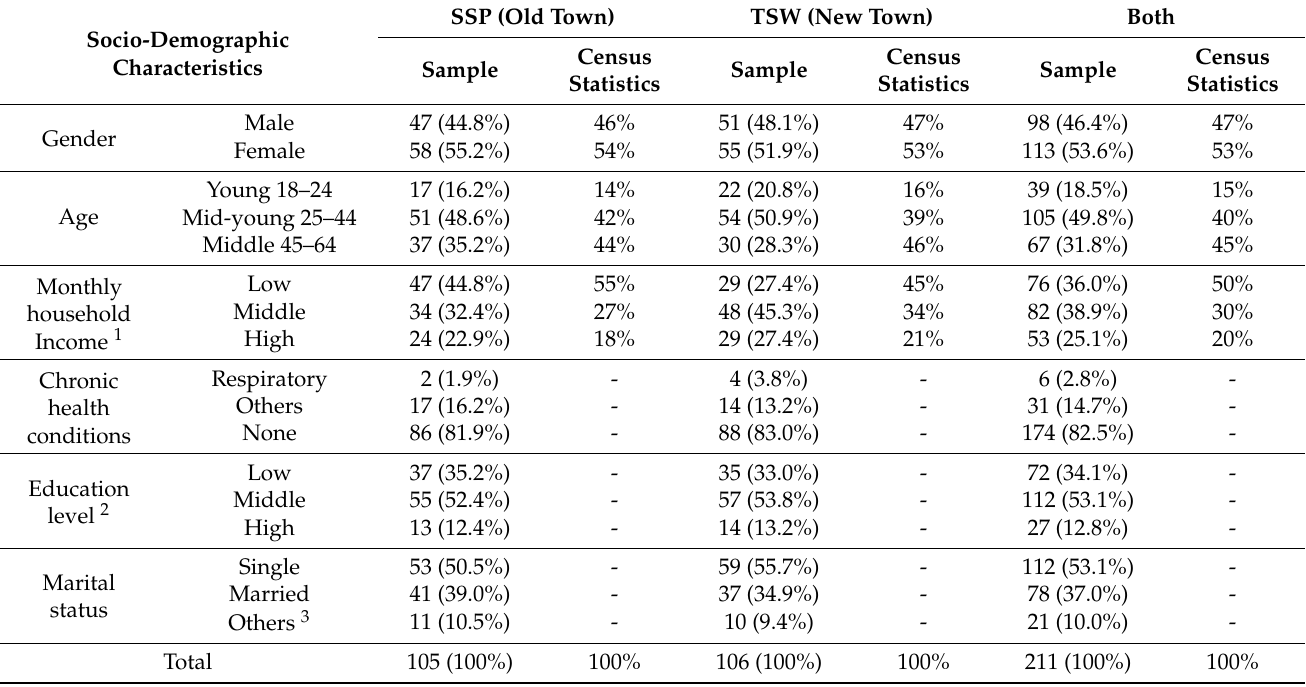
Table 1. The socio-demographic profile of investigated